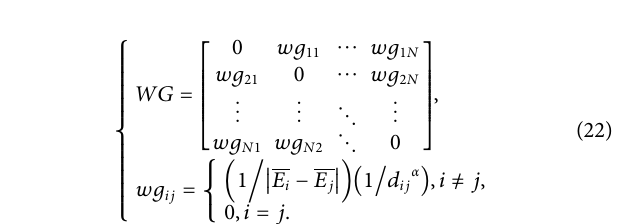
FIGURE 5 Gaussian spatial weight